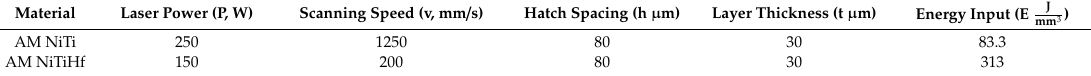
Table 1. The processing parameters employed during selective laser melting (SLM)